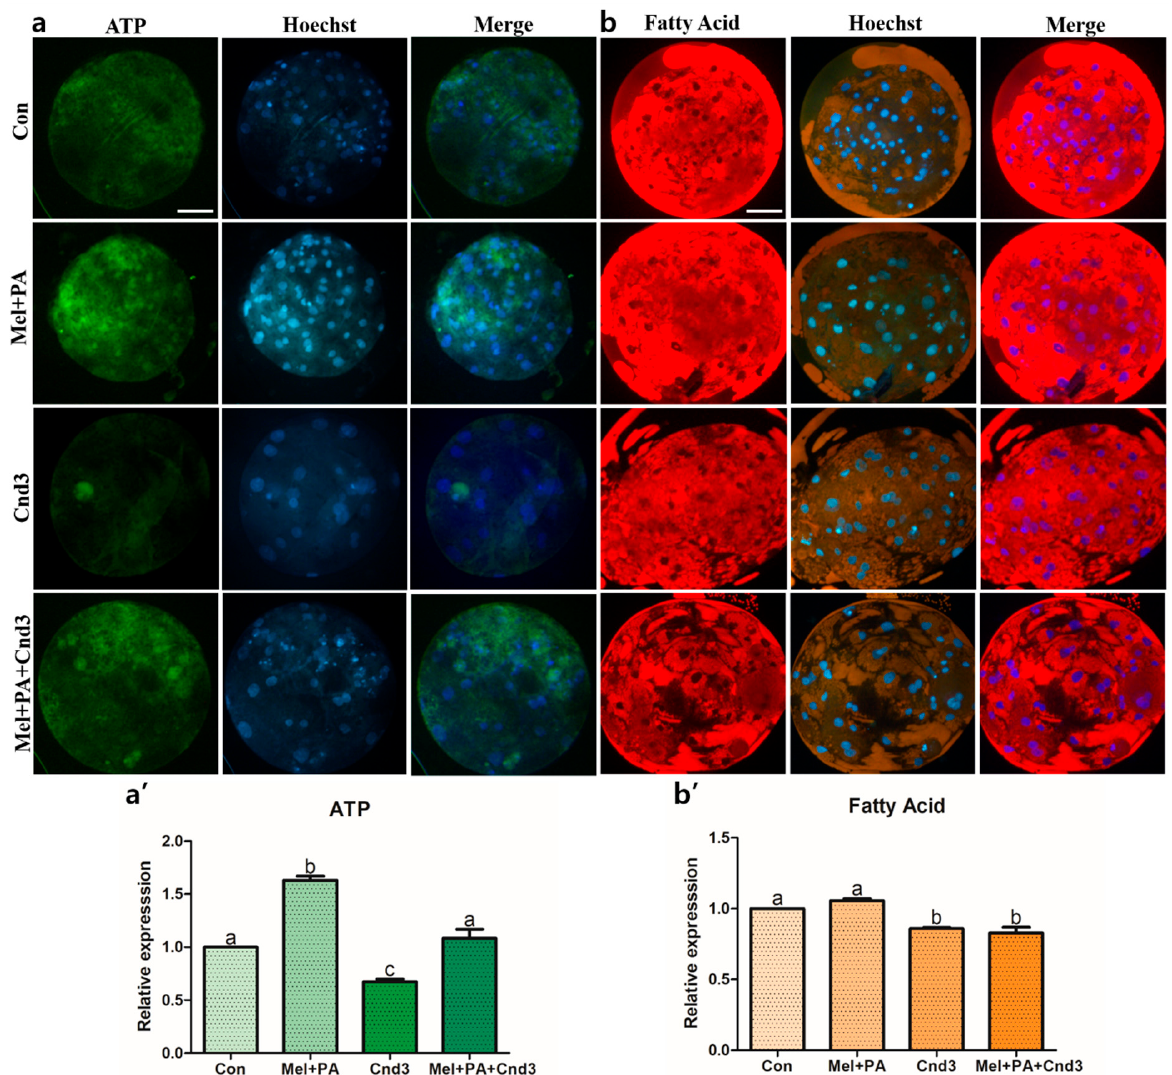
Figure 7. Representative images of BODIPY staining analysis of ATP contents and fatty acids in blastocysts. Fluorescence microscopy was applied to obtain images of the blastocysts. ( a , b ) Representative blastocysts in each group were stained with BODIPY FL ATP and BODIPY 558/568 C 12 , respectively, then counter-stained with Hoechst 33342. ( a’ , b’ ) Analysis of intensities from BODIPY FL ATP- and BODIPY 558/568 C 12 -stained blastocysts. At least 15 blastocysts from four biological replications in each group were used for the staining and it was performed three times technically. Data are shown as the means ± SEM. Bars with different alphabetical letters are significantly different ( p < 0.05). Con, control; mel, melatonin, PA, phytanic acid; Cnd3, siRNA candidate 3. White bars in the images indicate 50 μ m; 400× magnification.